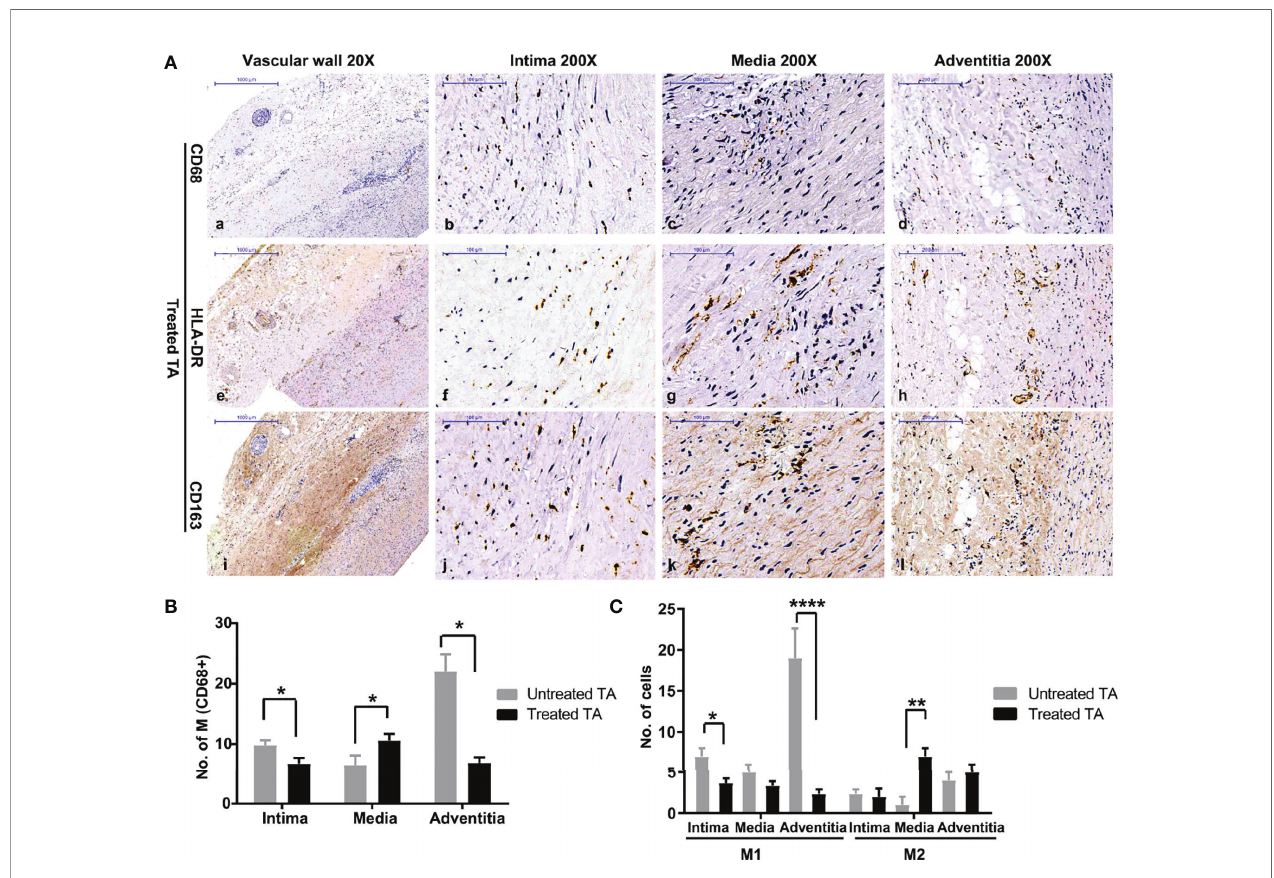
FIGURE 3 | Distribution and phenotype of macrophages in treated patients with TA (A) Representative images of CD68 (a – d), HLA-DR (e – h), and CD163 (i – l) positive cells in treated aorta. (B) Number of macrophages in different layers of untreated TA arteries, and treated TA arteries. (C) Number of M1 and M2 macrophages in vascular intima, media, and adventitia of untreated arteries, and treated arteries. *< 0.05; **< 0.01; ****<